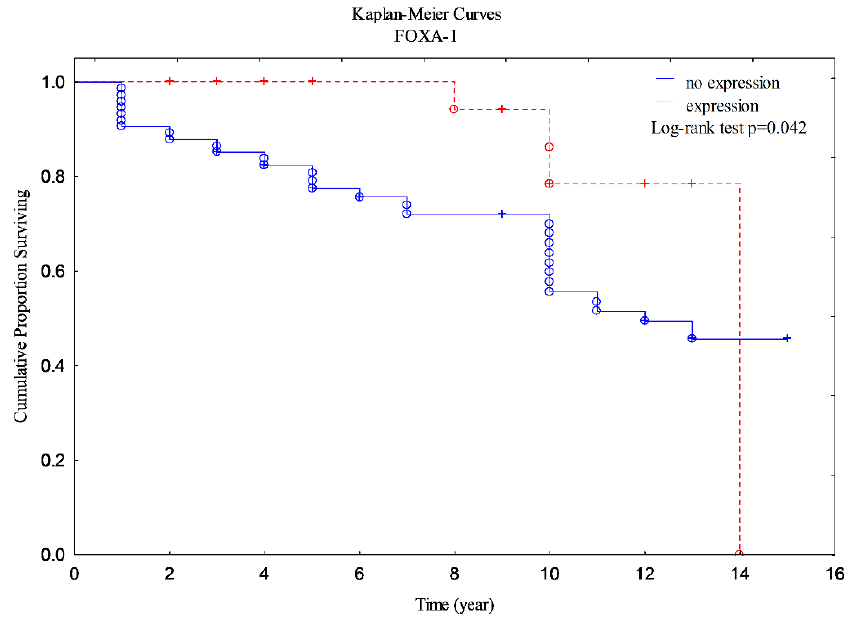
Figure 1. The Kaplan – Meier curves for FOXA1 ( p = 0.042).